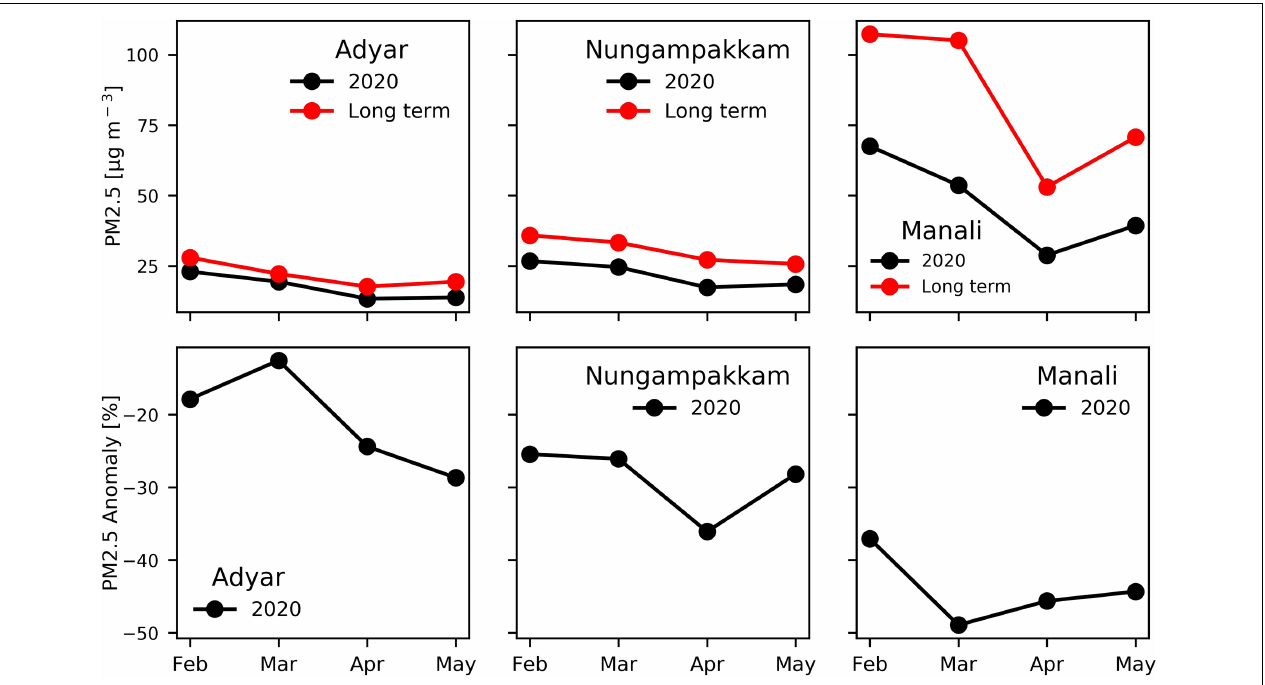
FIGURE 5 | Plots representing variations in monthly means and their percentage anomalies with long-term data of PM2.5 data at residential (Adyar), commercial (Nungampakkam), and industrial (Manali) zones.